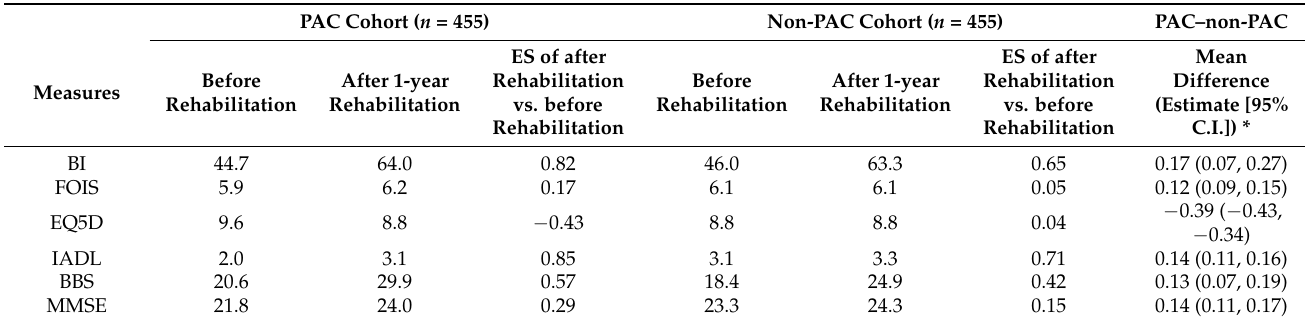
Table 3. Effect size (ES) and mean difference for total score of each functional status measure: comparison of post-acute care (PAC) and non-PAC cohorts.